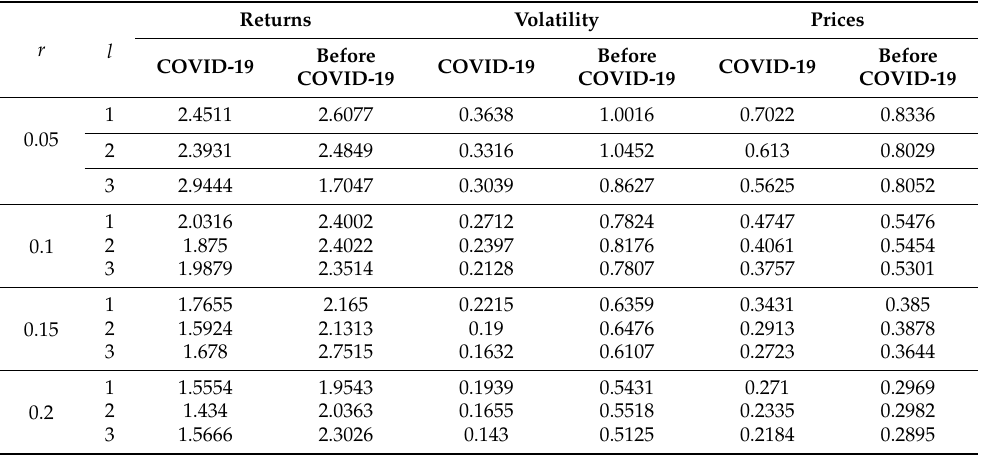
Table 7. Estimates of the approximate entropy for estimated volatility, closing prices, and closing returns of